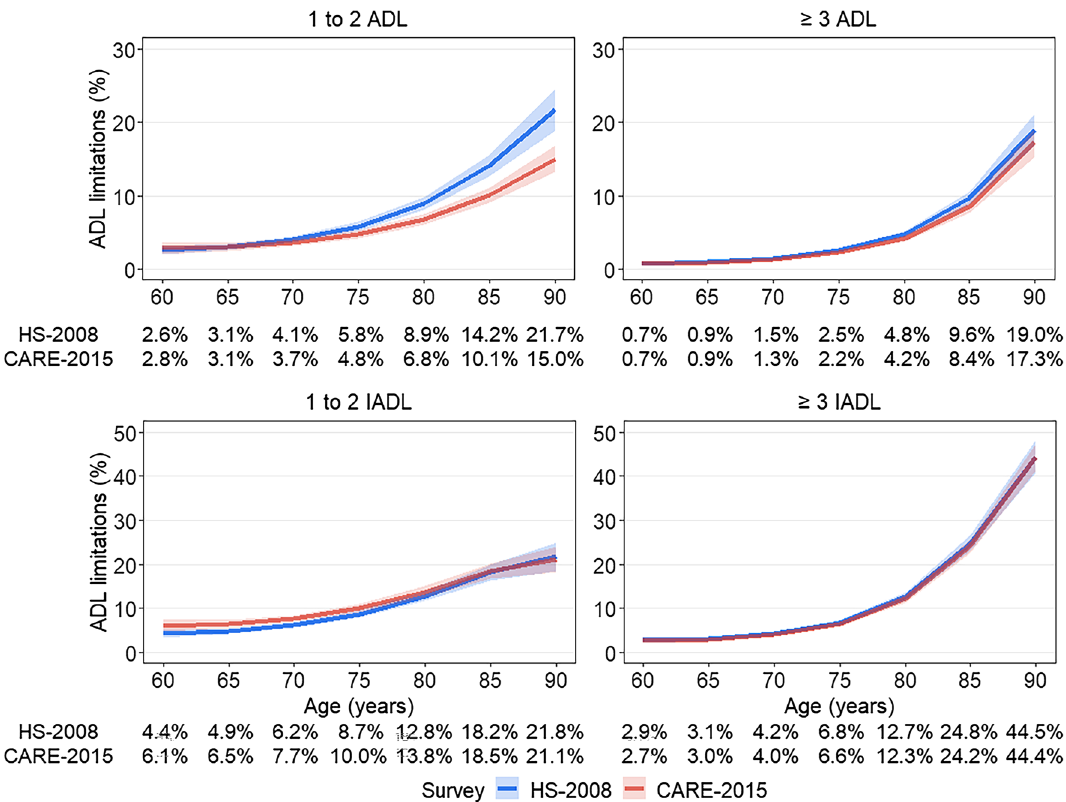
Figure 3. Prevalence of ADL and IADL limitations in HS-2008 and CARE-2015 survey, by age and number of reported limitations a . HS: Handicap Santé,;CARE: Capacities, Aids and REssources; ADL: Activities of Daily Living; IADL: Instrumental Activities of Daily Living. a Estimated using weighted multinomial models for 1–2 and ≥ 3 limitations, and adjusted for survey (HS-2008, CARE-2015), age, age 2 , survey x age, sex, multimorbidity, education, and for significant interactions between covariates and age